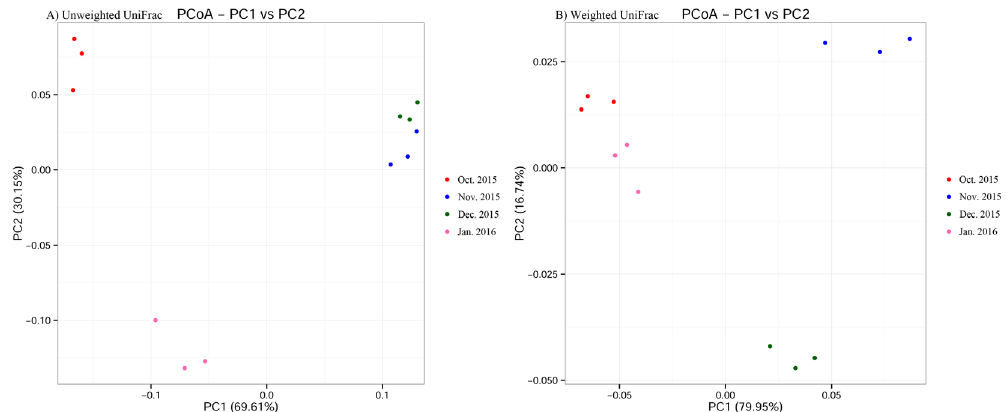
Figure 9. Two-dimensional principal coordinates analysis (PCoA) plot of unweighted ( A ) and weighted ( B ) unifrac distance matrices for Dendroctonus armandi larvae in each month from October 2015 to January 2016.